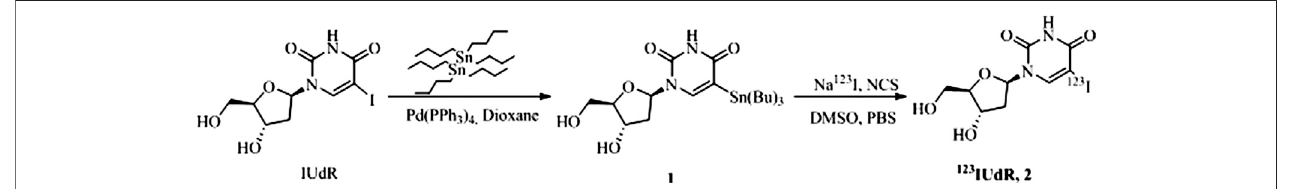
FIGURE 1 | Synthesis and labeling scheme of 123 I-iododeoxyuridine,